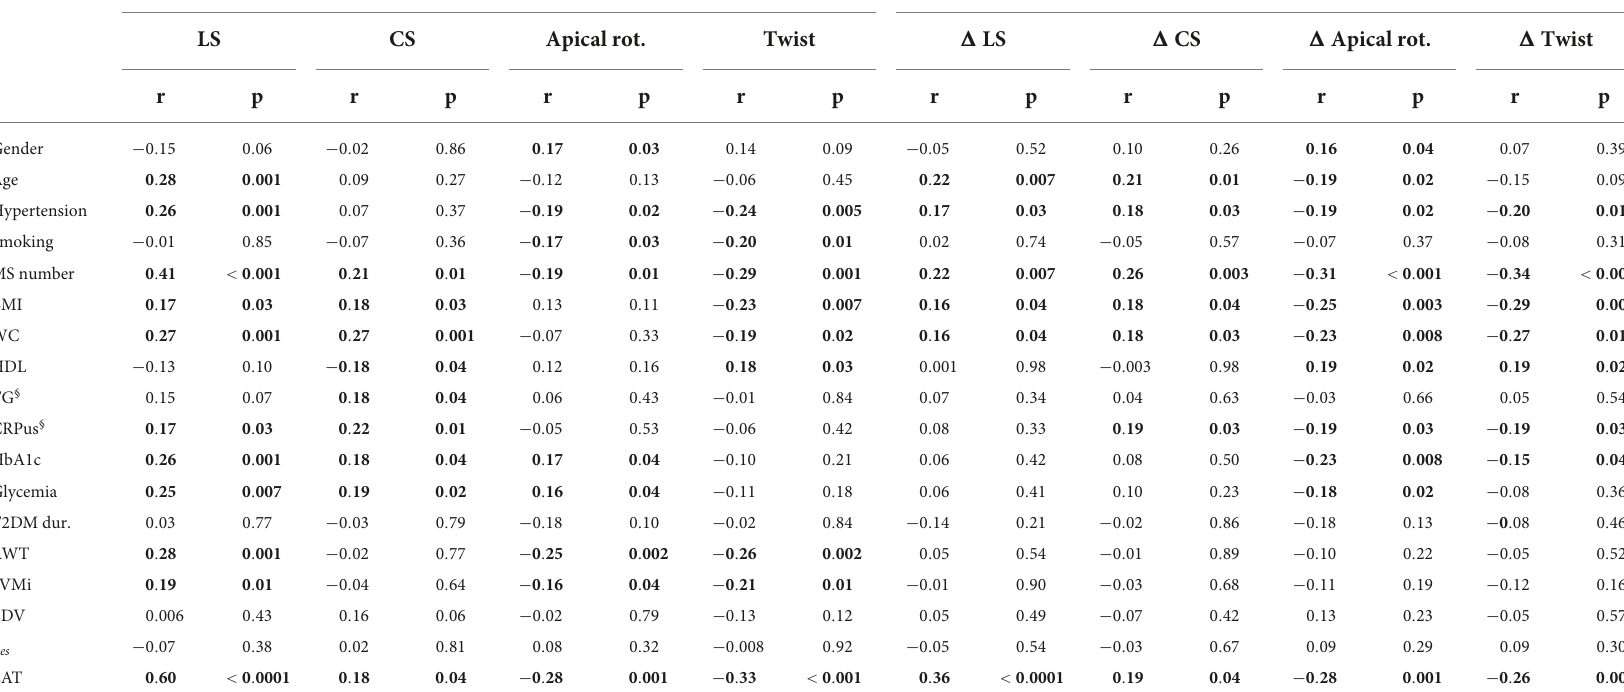
TABLE 4 Univariate and multivariate correlation analysis of delta changes in STE indexes with clinical, biological and echocardiographic indexes. Dobutamine Univariate LS CS Apical rot. Twist (cid:49) LS (cid:49) CS (cid:49) Apical rot. (cid:49)